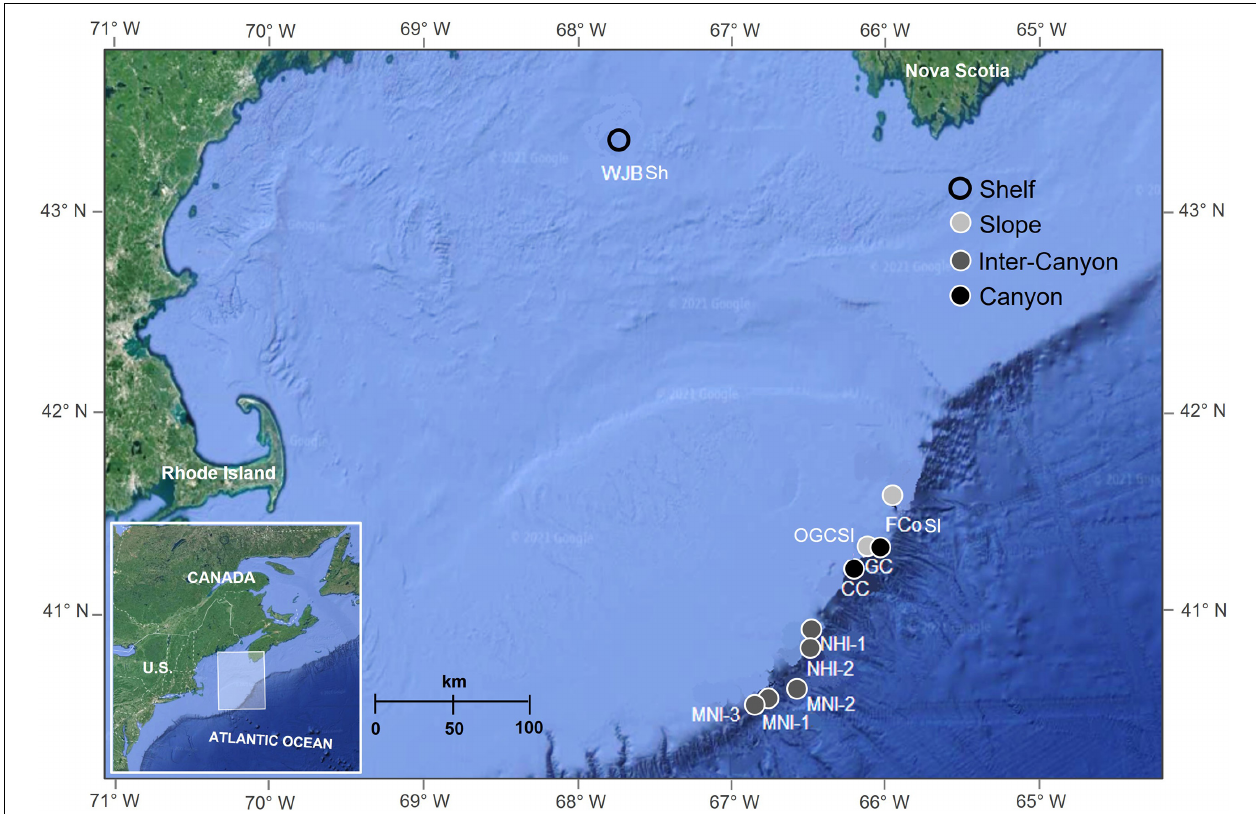
FIGURE 1 | Map showing sampling area and the 10 stations sampled in June 2017 in order to evaluate inorganic nutrient fluxes at the sediment-water interface, macrofauna, and environmental characteristics.